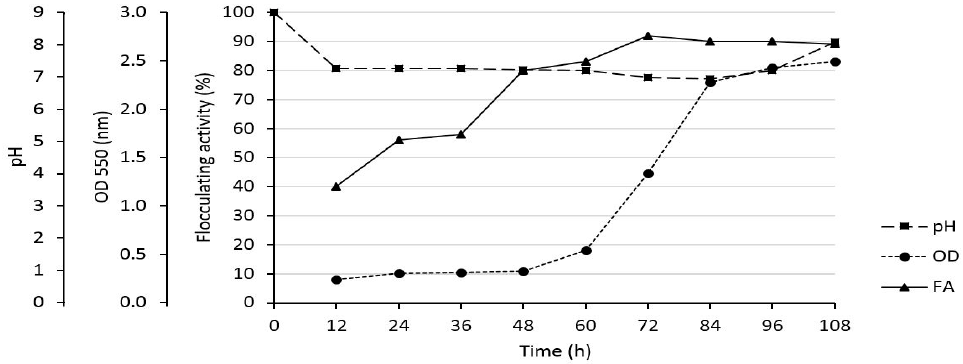
Figure 4. The effect of time on FA, initial pH and OD. Figure 4. The e ff ect of time on FA, initial pH and